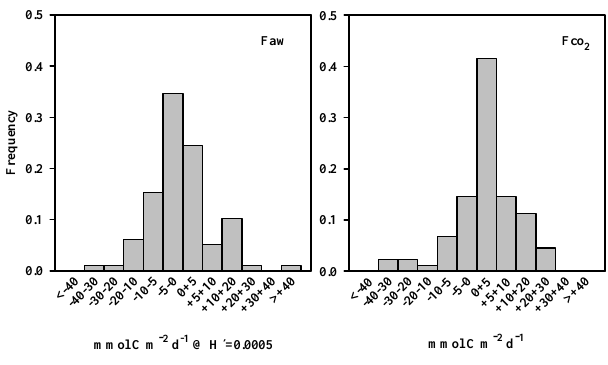
Figure 6. Frequency distribution of air–sea fluxes of exchangeable organic carbon ( F aw ) and F CO (mmolm − 2 d − 1 ). Data binned in 2 10mmolCm − 2 d − 1 intervals except close to 0, where it was binned in 5mmolCm − 2 d − 1